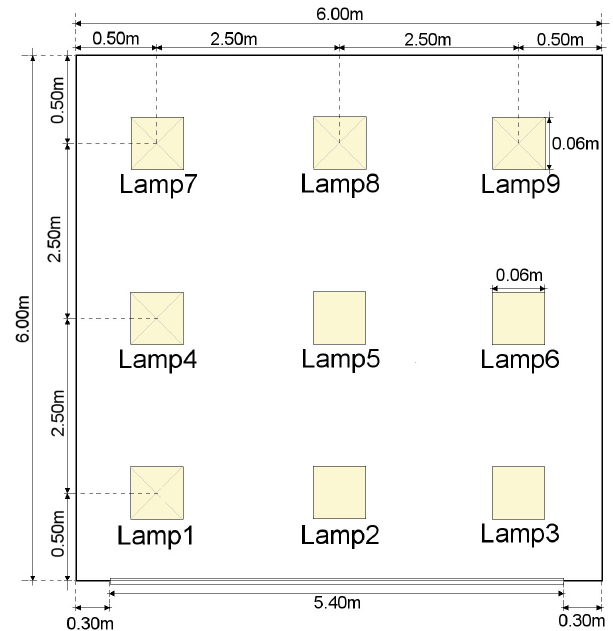
Figure 3. Room Configuration. In the scenario, the emitters are located in a room 6 m wide by 6 m deep by 3 m high. In the scenario’s room, there are nine luminaries with a power output of 12 W per luminary. Each luminary is composed of 100 individual LEDs and each luminary is a square one.